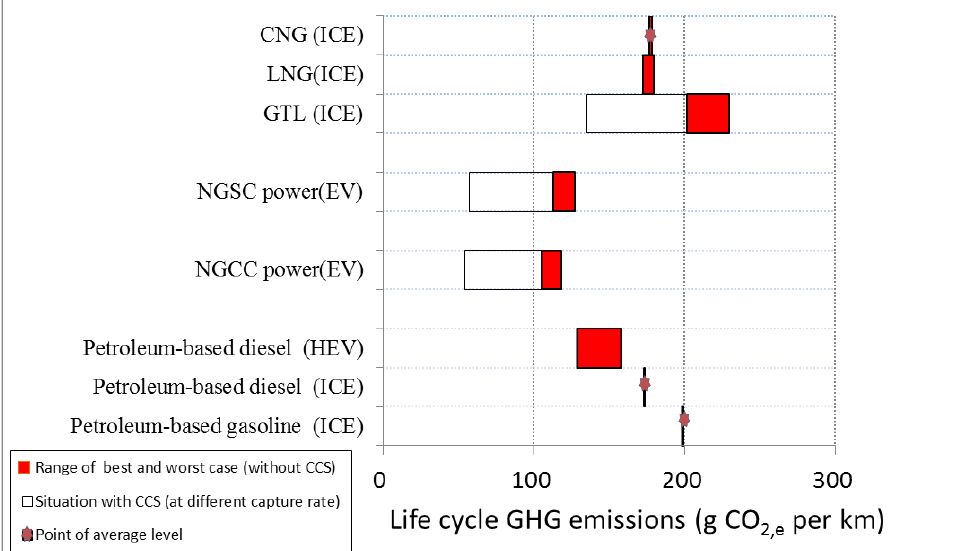
Figure 2. Comparing life cycle GHG emissions of petroleum-based fuels and NG-based fuels by different technologies. (1) Emissions from fuel-cycle and vehicle-cycle are all included; (2) Without CCS, bars depict ranges of highest efficient system configuration (left end point) to least efficient system configuration (right end point); (3) With CCS, bars depict ranges of different rate for CO capture 2